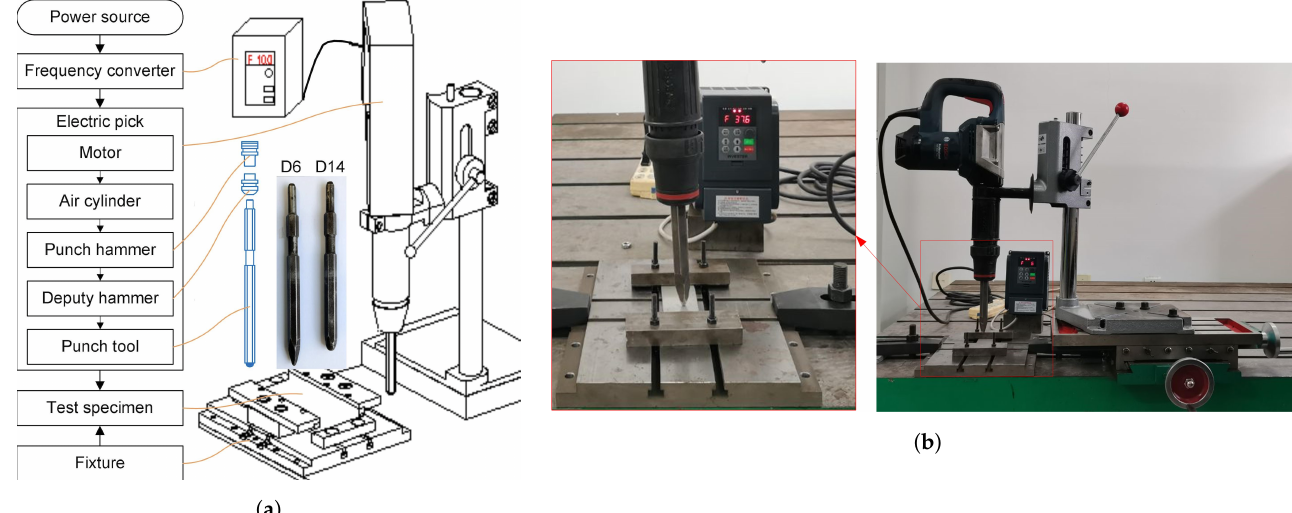
Figure 2. ( a ) Device of combined hammering (D6-head diameter of punch tool is 6 mm, D14 is 14 mm, Ra0.8), ( b ) the sliding table on the right side control the impact